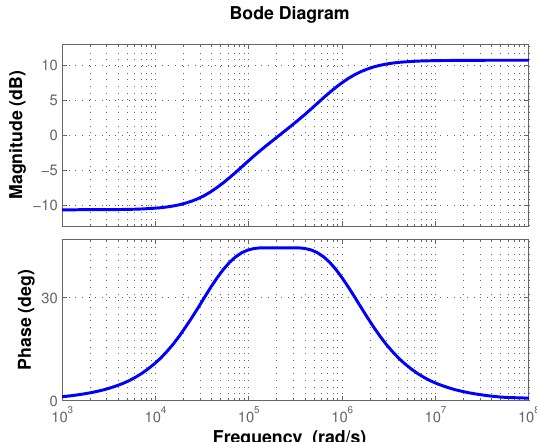
Figure 5. Frequency response with flat–phase characteristic centered at ω gc for the approximation (5), where ω gc is the gain crossover frequency of (4).